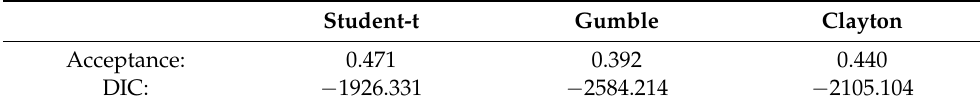
Table 4. Model selection results for MS-GARCH copula.